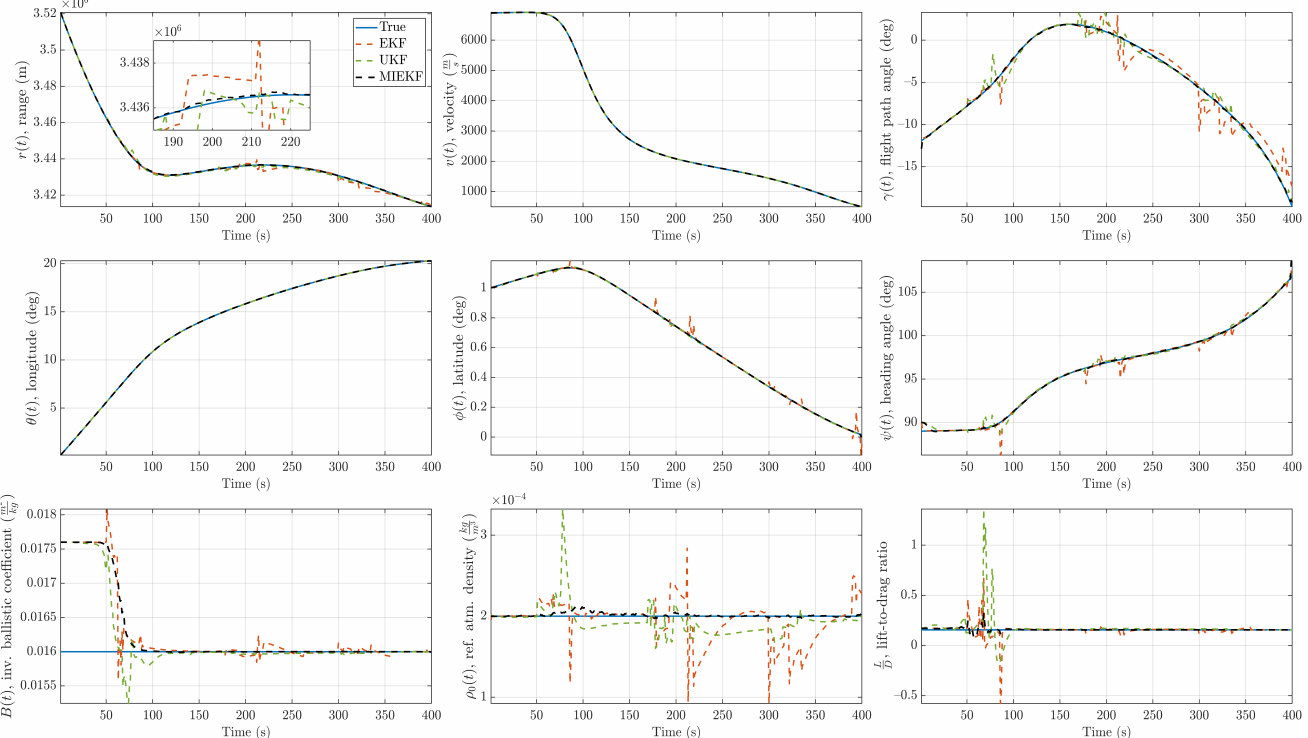
Figure 11. State estimation performance comparison for 20% outlier contamination ( (cid:101) =